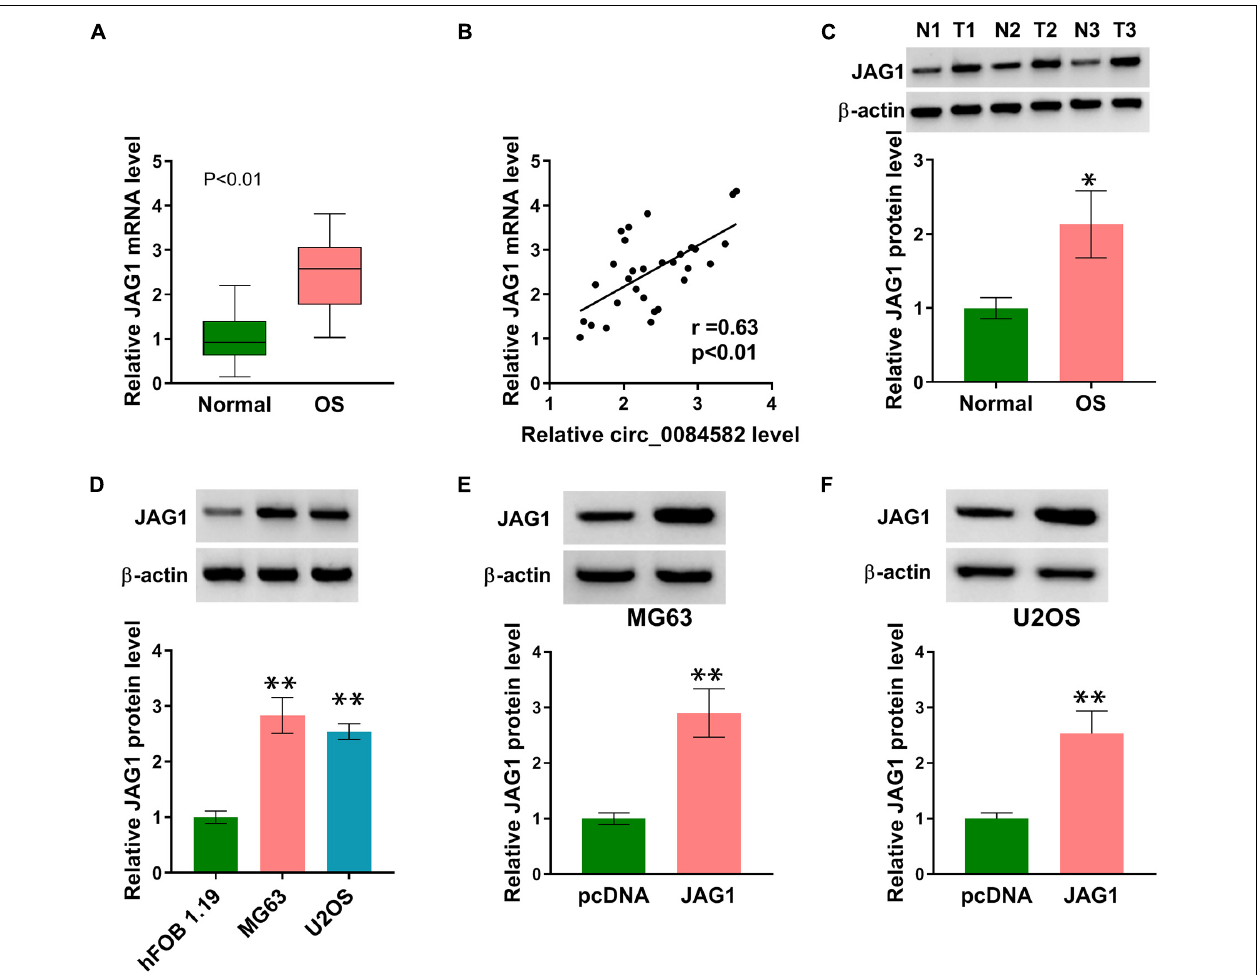
FIGURE 3 | JAG1 was overexpressed in OS samples and cells. (A) The mRNA level of JAG1 was quantified via qRT-PCR in OS samples. (B) The linear relationship between circ_0084582 and JAG1 was analyzed via Pearson’s correlation coefficient. (C,D) JAG1 protein expression was measured via Western blot in OS samples (C) and cells (D) . (E,F) The transfection efficiency of JAG1 was assessed via Western blot in MG63 and U2OS cells. All experiments were performed with three biological replications. ∗ P < 0.05, ∗∗ P <